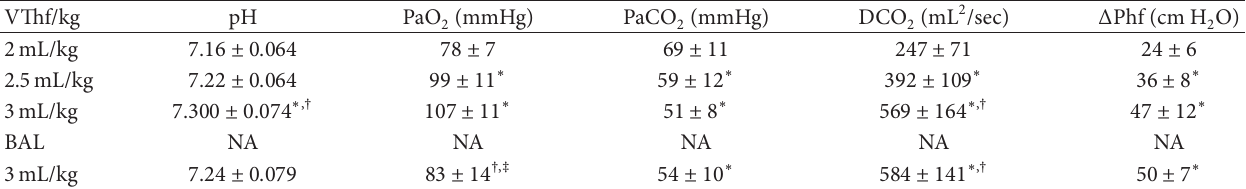
Table 2: Physiological variables at different volumes guarantee before and after surfactant depletion by BAL. VThf/kg pH